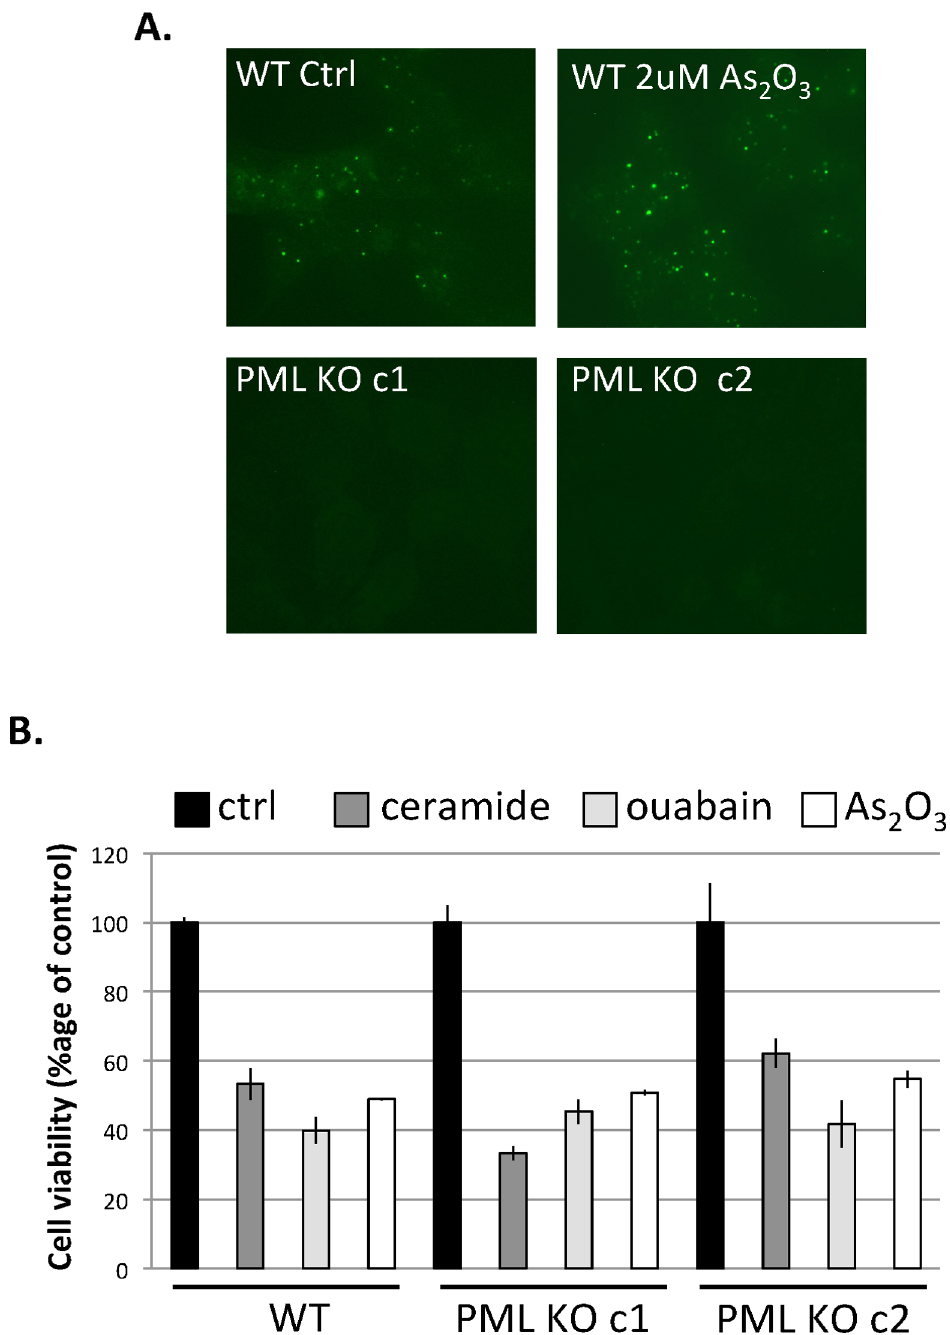
Fig 5. Loss of PML does not attenuate cell death induced by apoptotic stimuli. Two PML knockout HEK293T cell clones (PML KO c1 and c2) were generated by CRISPR/Cas9 approach. A, PML protein levels were determined by immunofluorescence using anti-PML antibody in the control and 2 μ M arsenic trioxide (As 2 O 3 )-treated wild type HEK293T (WT), as well as in two PML knockout clones (PML KO c1 and c2). B, Wild-type and knockout clones were cultured in 96 well plates at a density of 15,000/well. The next day, the cells were treated with 60 μ M C2-ceramide, 300nM ouabain or 5 μ M arsenic trioxide for 48h. Cell viability was determined using Cell Titer Glo assay. Data are mean ± SEM (n = 3).